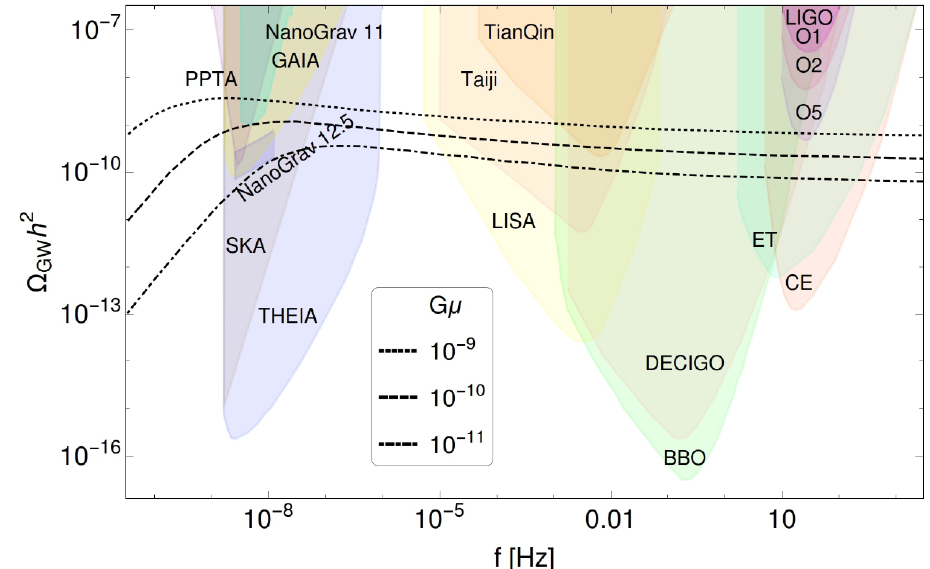
Figure 2 . Gravitational wave signals from stable cosmic string networks as a function of frequency observed today together with the corresponding sensitivities of the indicated observatories. See text for